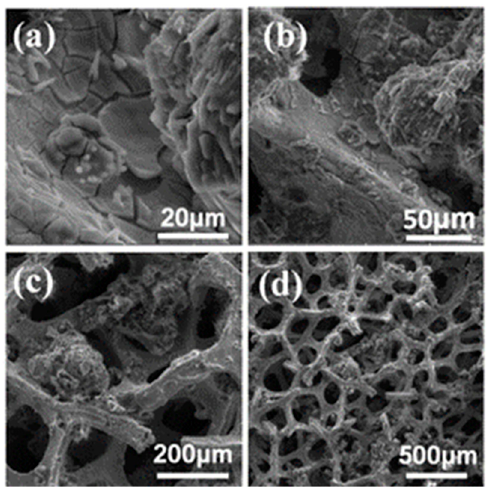
Figure 4. SEM images showing phase structure and morphology of bare GM2 foam at di ff erent magnification levels: ( a ) 20, ( b ) 50, ( c ) 200, and ( d ) 500 µm.